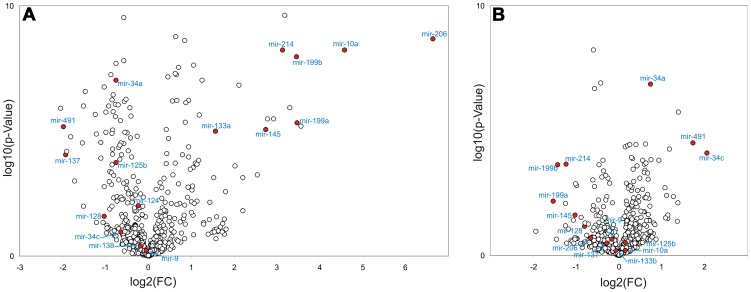
Volcano plots comparing VPA and arsenite miRNA signatures 16 days after neural differentiation of mESCs.The –log10 of P-values for each miRNA are plotted against log2 mean ratio (three replicates) of the normalized miRNA signals of treated samples compared to solvent control. A. VPA induced changes in miRNA profile of neural-differentiated mESCs. B. Arsenite effects on miRNA expression in neural-induced mESCs. miRNAs which were included in further qPCR analysis or were regulated in opposite direction by both substances are marked in red.